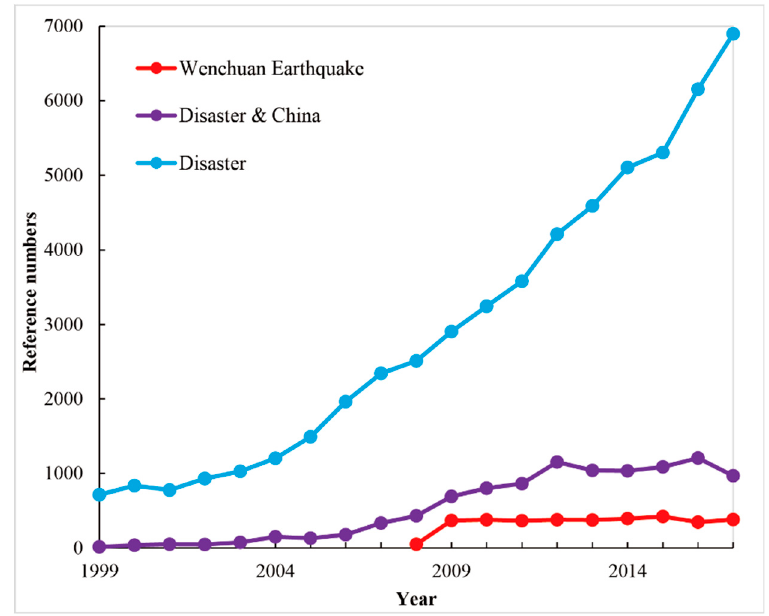
Figure 2 . Numbers of disaster research articles from 1999 to 2017. Figure 2. Numbers of disaster research articles from 1999 to